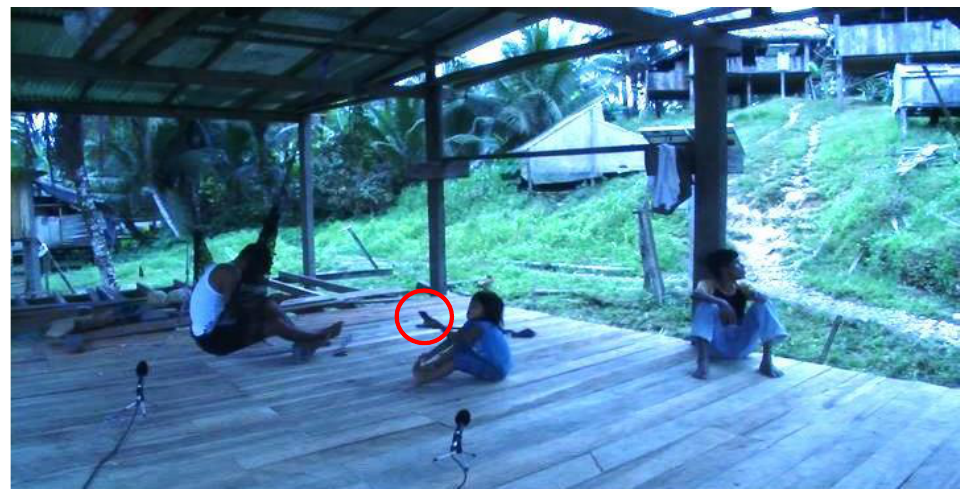
Figure 3. A pointing gesture forms part of a repair solution, adding more information to a specification of place